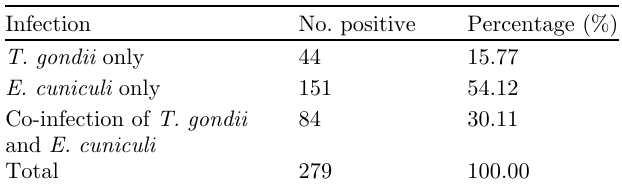
Table 3. Frequency of single infection and co-infection in all 279 infected